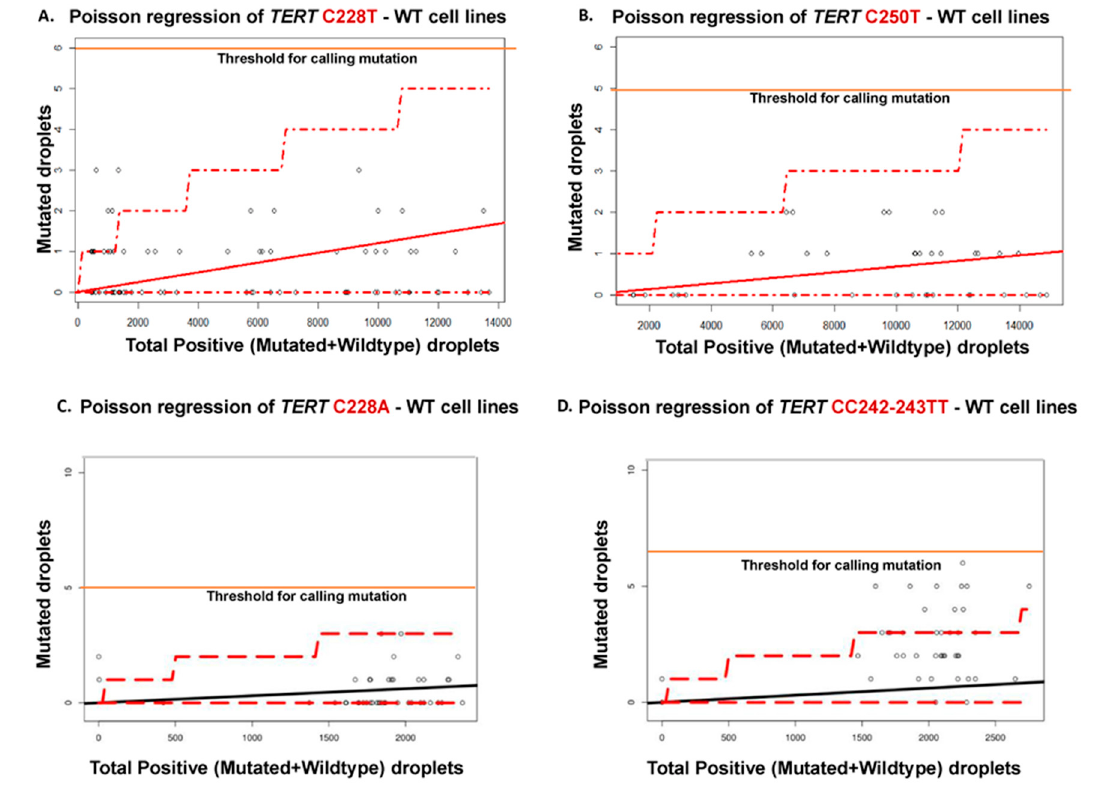
Figure 2. Determination of the threshold number of minimum droplets for calling a mutation. Poisson regression was generated from the number of droplets obtained from channel 1 (for mutated probe) and channel 2 (for wildtype probe) of 20 wildtype cell-lines for the C228T ( A ), C250T ( B ), C228A ( C ) and CC242-243TT ( D ) ddPCR assays. From this regression, the threshold for calling C228T, C250T, C228A and CC242-243TT mutations was set at 6, 5, 5 and 6 positive/mutated droplets, respectively.